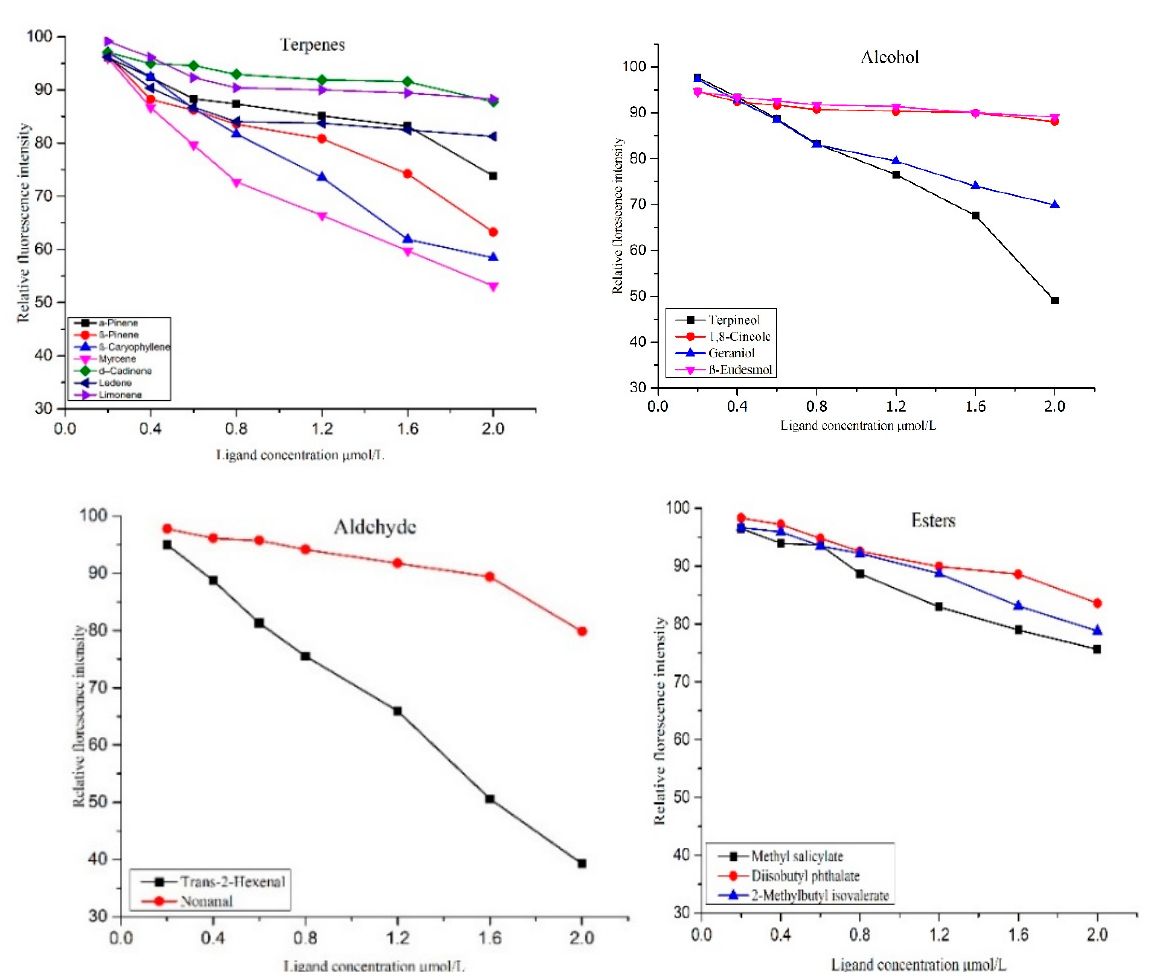
Figure 7. Competitive binding curves of CcreOBP6 to different ligands including terpenes, aldehyde, alcohol, and esters.